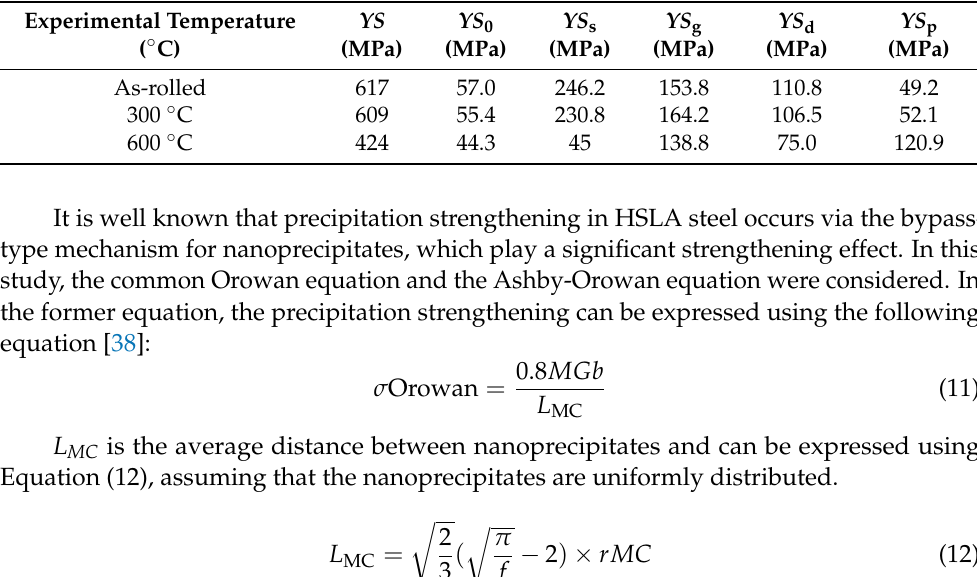
Table 4. The various strengthening contribution values of experimental